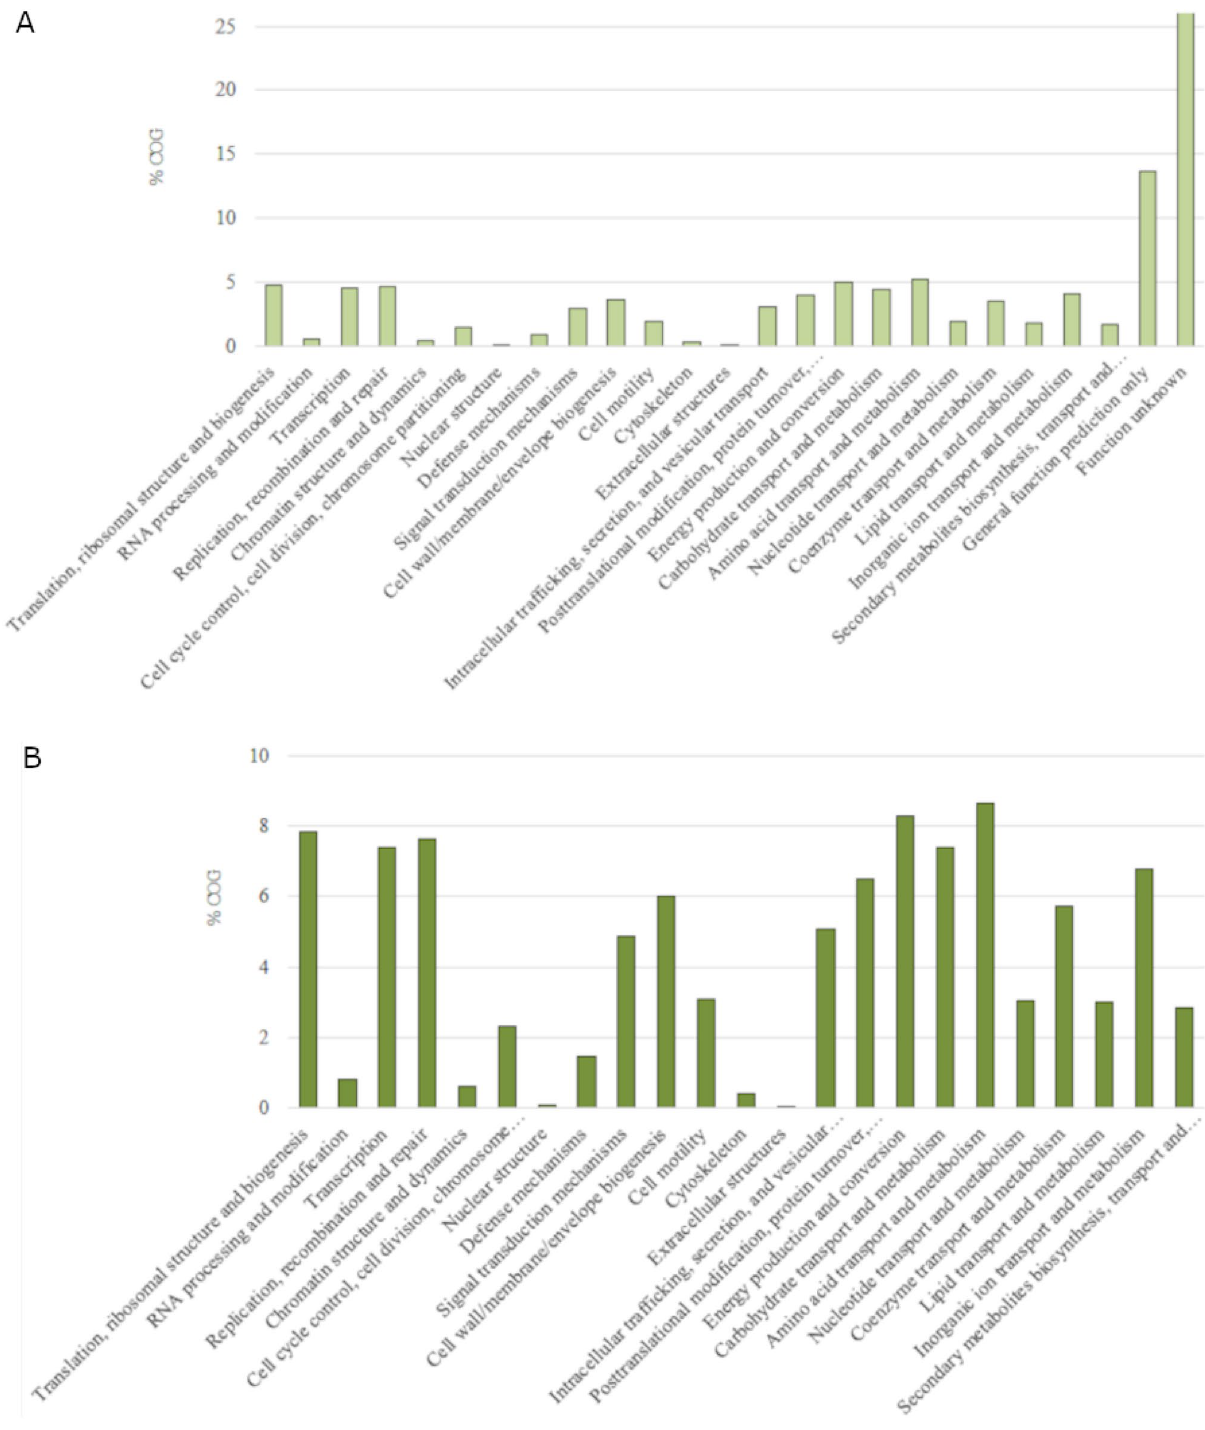
Figure 5. COG distribution of P. psychrophila KM02